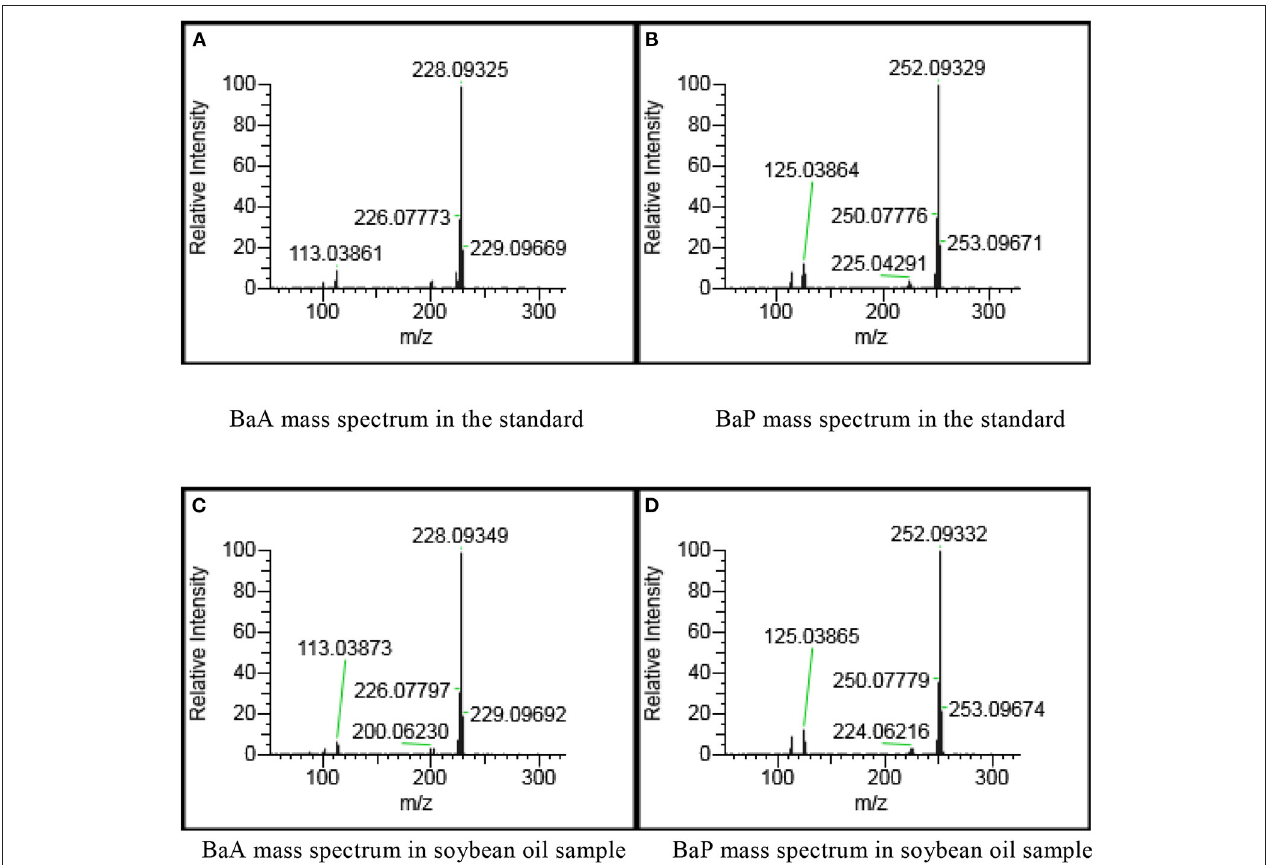
FIGURE 3 | Mass spectrogram of reference materials and positive soybean oil sample at 50 µ g/kg. (A) BaA mass spectrum in the standard. (B) BaP mass spectrum in the standard. (C) BaA mass spectrum in soybean oil sample. (D) BaP mass spectrum in soybean oil